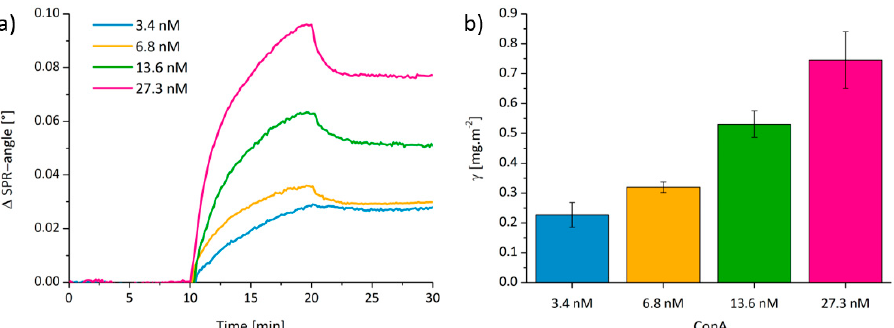
Figure 2. ( a ) SPR sensograms showing the adsorption of ConA at different concentrations on cellulose surfaces with pre-adsorbed GM (injection at t = 10 min, rinsing at t = 20 min) and ( b ) corresponding calculated protein adsorption after rinsing with buffer. Measurements were performed in triplicates at λ = 785 nm using PBS as buffer (flow rate: 20 µl ∙ min − 1 ).